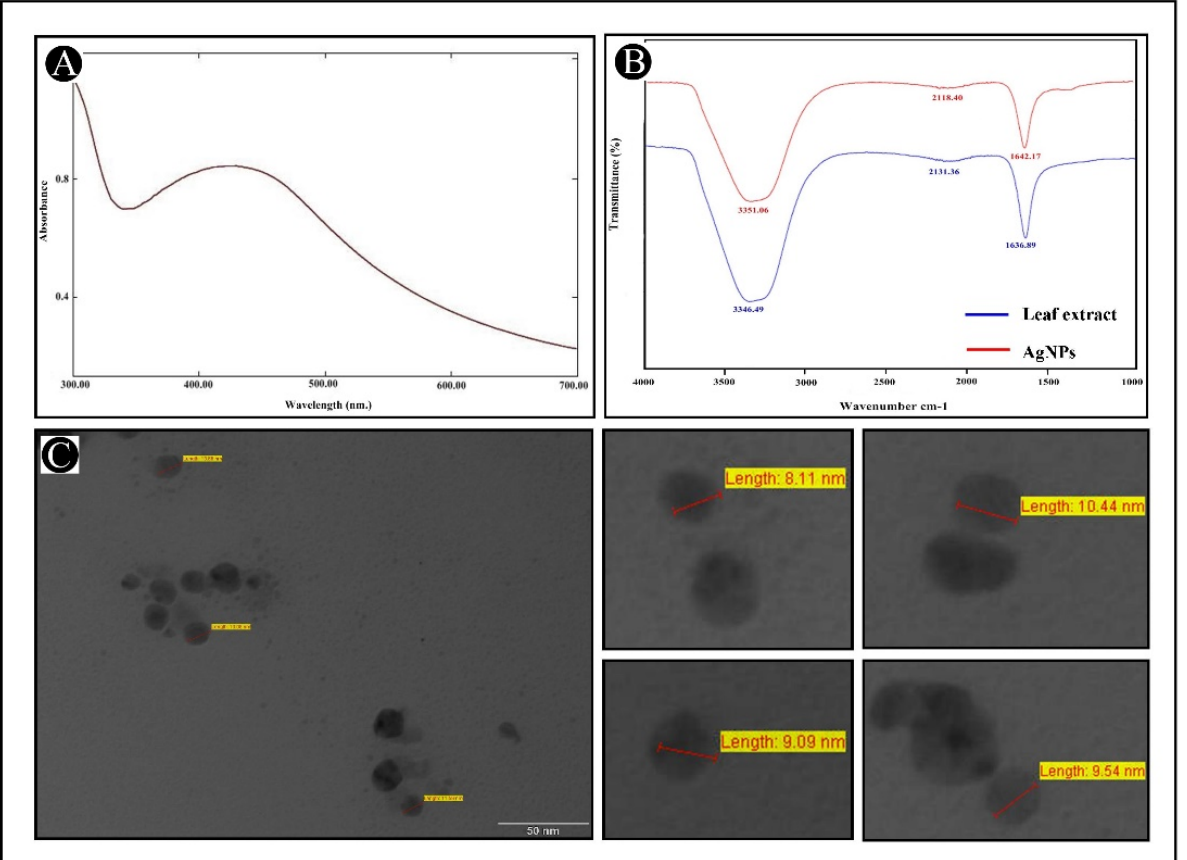
Figure 1. Characterization of E. sativa -leaf-extract-capped silver nanoparticles (AgNPs). ( A ) UV– visible absorption spectra of synthesized AgNPs. ( B ) FT-IR pattern of E. sativa leaf extract and synthesized AgNPs. ( C ) Morphological analysis of synthesized AgNPs with variable diameter using TEM micrograph.